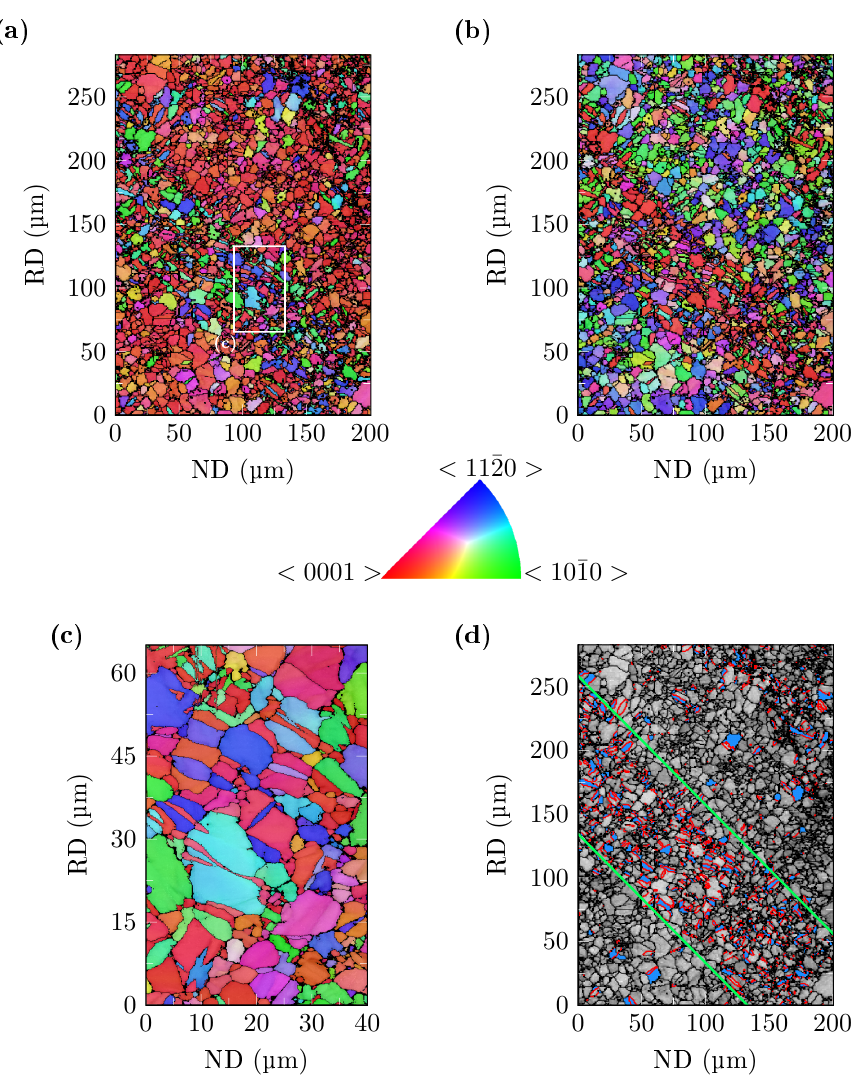
Figure 7. EBSD measurement with view in TD of the structural component specimen BS9-003 made of AZ31B after the bending process: ( a ) orientation map including a BTG with scanning step size of 1.00µm and reference view in ND; ( b ) orientation map including a BTG with scanning step size of 1.00µm and reference view in RD; ( c ) orientation map within the BTG with reference view in ND and scanning step size of 0.115µm; ( d ) band contrast with detected red lines and borders of BTG marked with green lines.